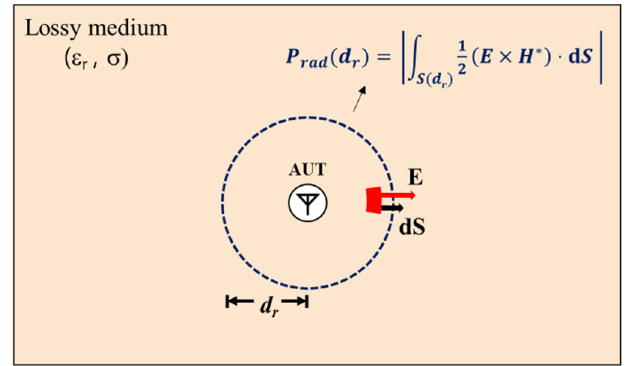
Figure 2. Simulation setup for calculation of radiated power.